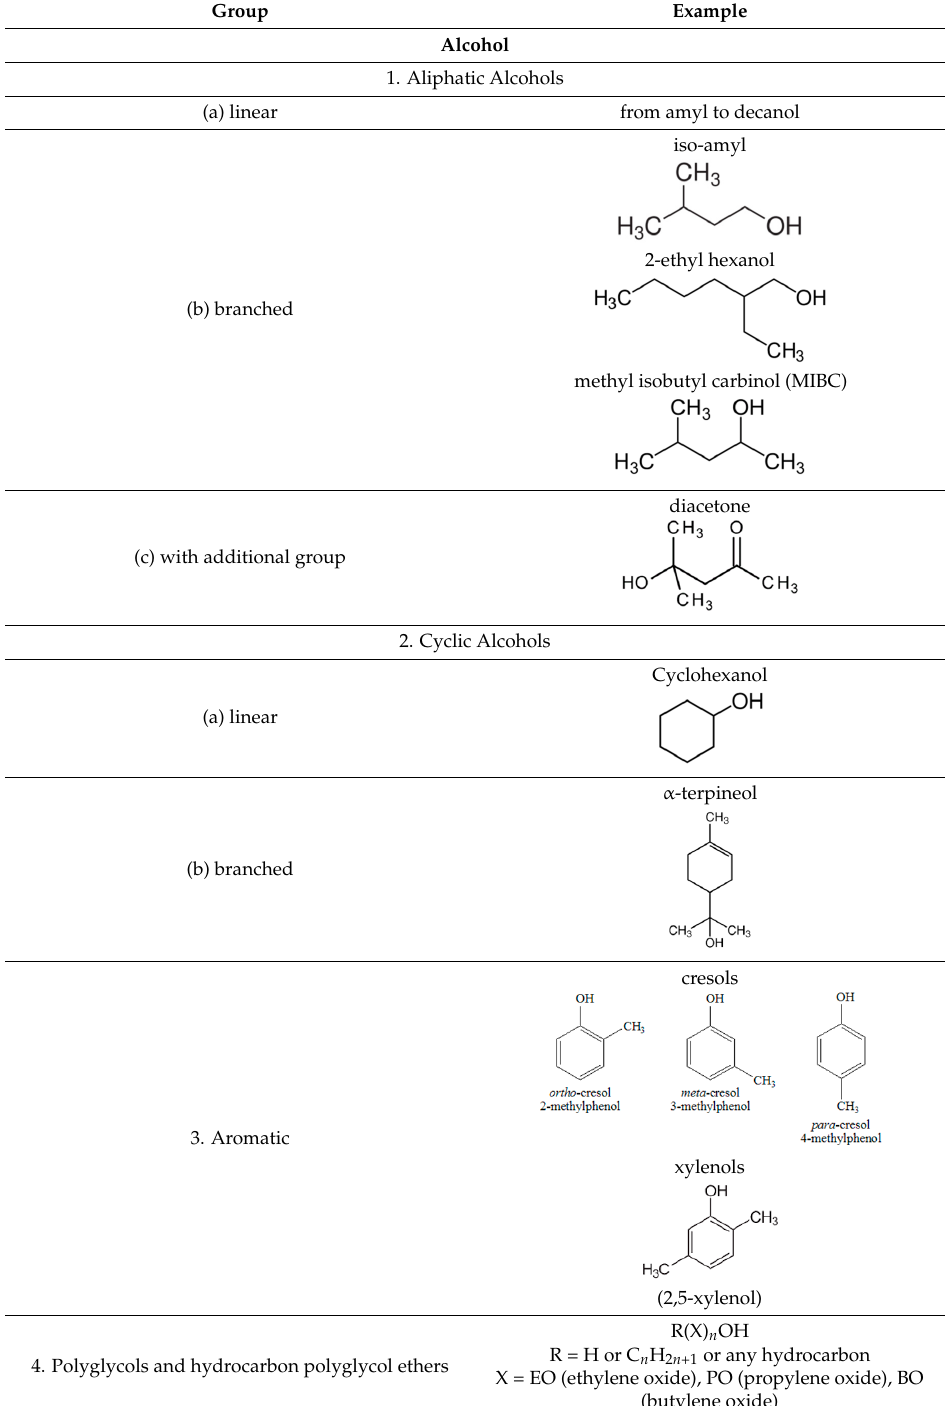
Table 3. Classification of organic frothers into alcohols and non-alcohols ([18], with modifications).